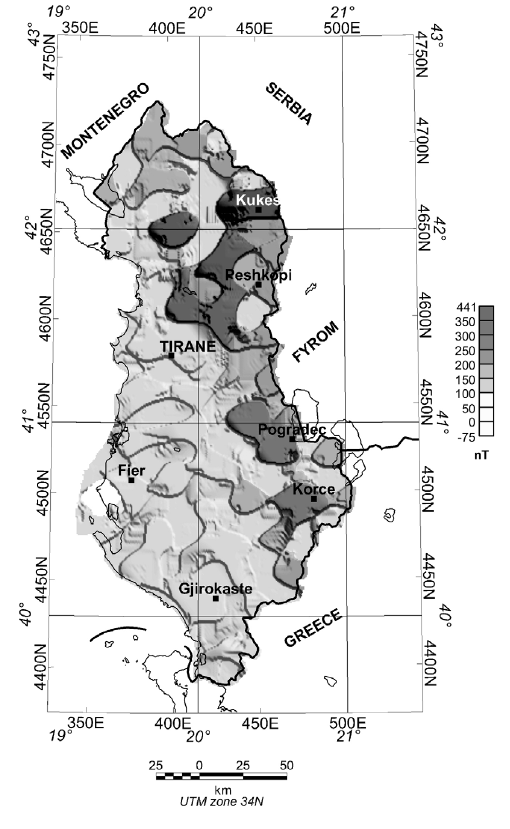
Fig. 9. The result of «terracing» applied to the total field magnetic anomaly of Albania after the removal of all wavelengths smaller than 20